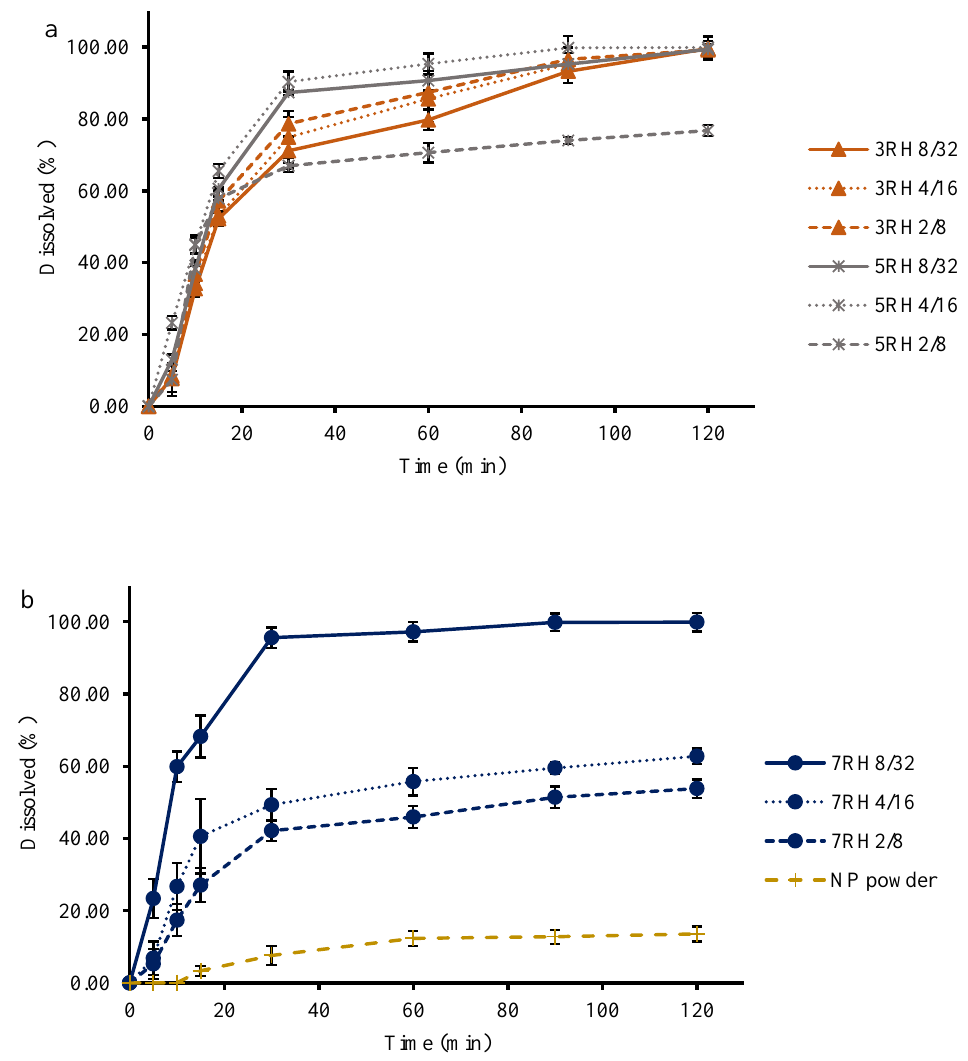
Figure 4. Dissolution of dry NP powder in ( a ) 3RH2/8, 3RH4/16, 3RH8/32, 5RH2/8, 5RH4/16, Figure 4 Dissolution of dry NP powder in a) 3RH2/8, 3RH4/16, 3RH8/32, 5RH2/8, 5RH4/16, and 5RH8/32 and in b) 7RH2/8, 7RH4/16, 7RH8/32, and NP powder alone.